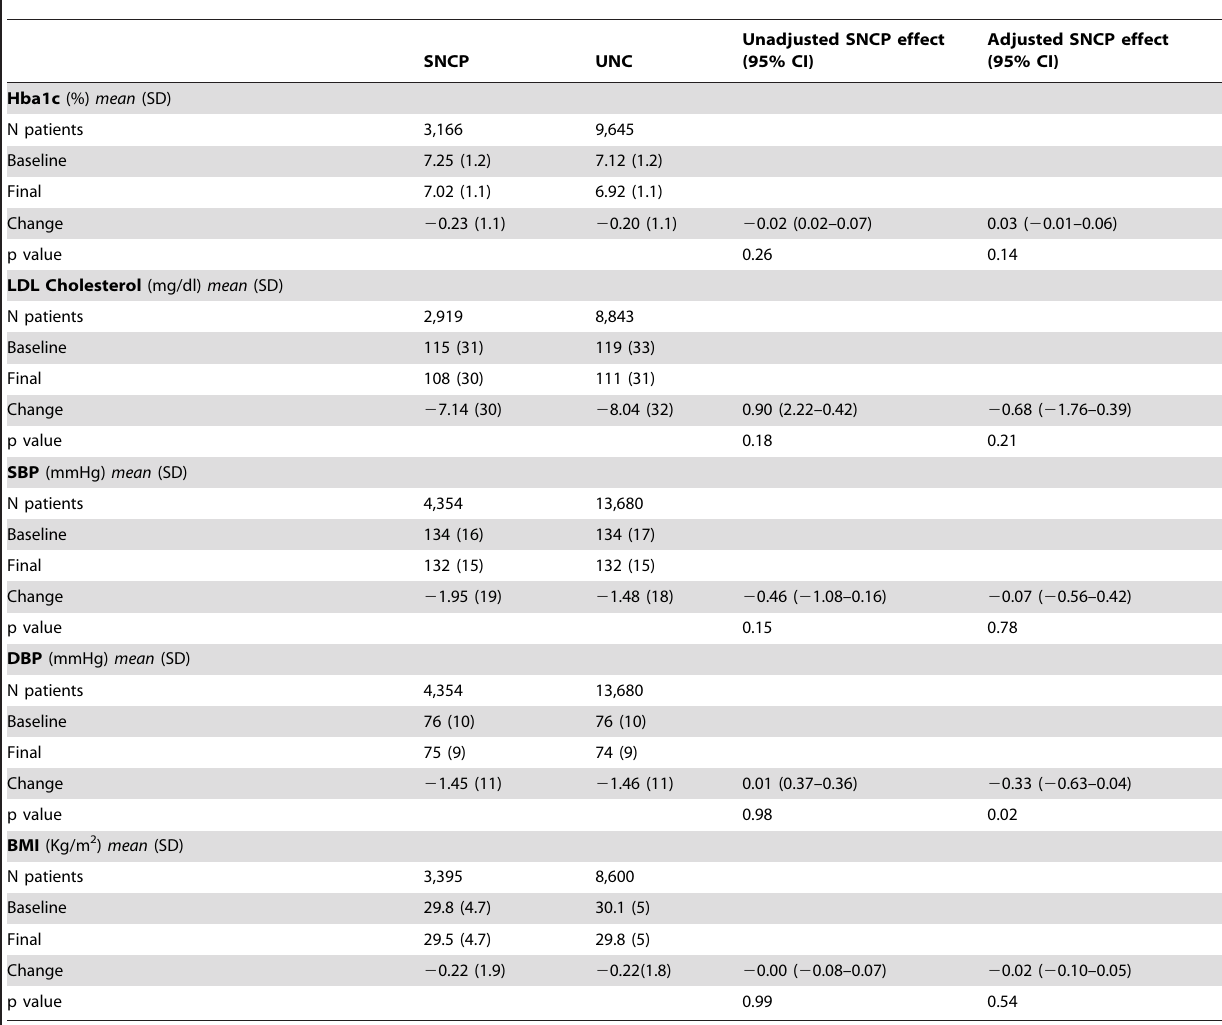
Table 4. Mean values (SD) and changes of baseline and final parameters in both